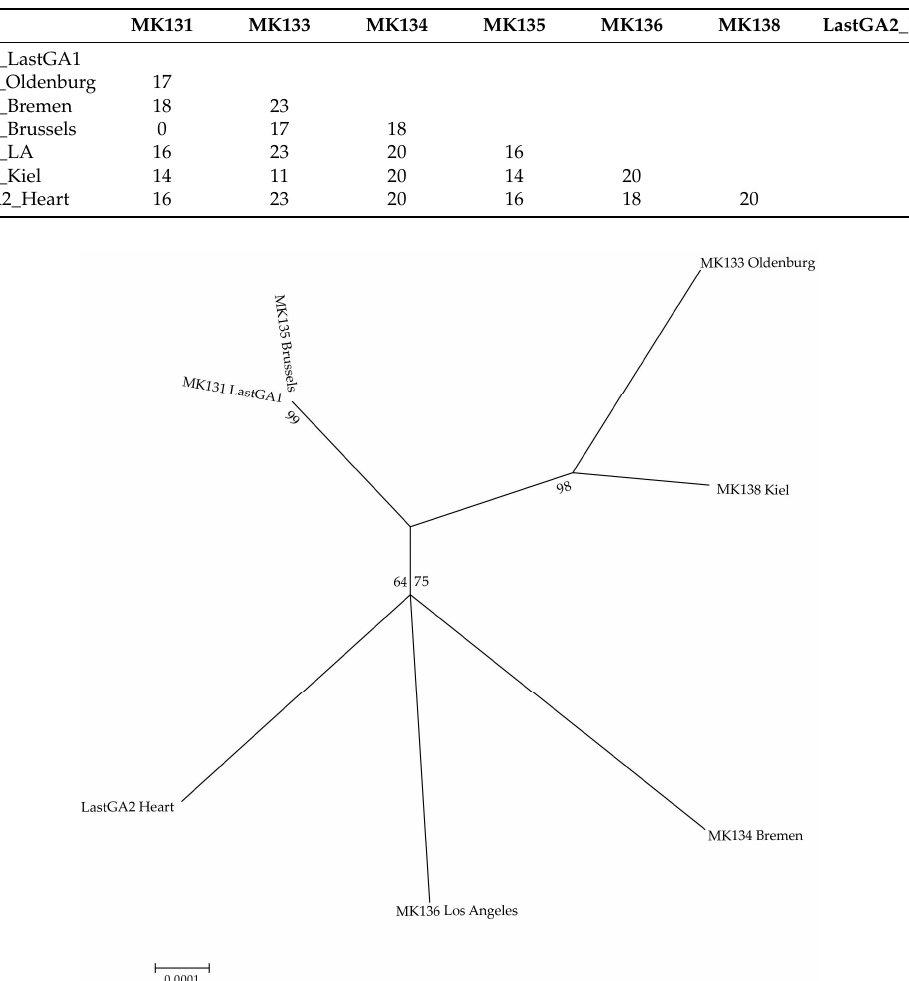
Table 3. Pairwise distance matrix. Estimates of evolutionary divergence between sequences generated using the relaxed settings. The number of base differences per sequence from between sequences are shown. All positions containing gaps and missing data were removed, leaving a total of 15,790 positions in the final dataset. Evolutionary analyses were conducted in MEGA7 [35].